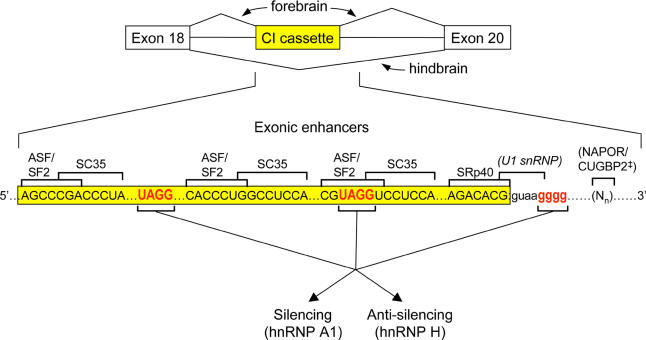
Model for Differential Regulation of the CI Cassette Exon by the Interplay of hnRNP A1 and H and a Ternary Motif PatternAt the top is a schematic of intron/exon structure and prominent splicing patterns observed in the forebrain (top) and hindbrain (bottom) of rat brain. Below is a summary of splicing regulatory motifs functionally defined in this study depicted on an expanded version of the GRIN1 CI cassette exon (yellow). ESEs are indicated above the exon. Nucleotides complementary to U1 small nuclear RNA and the interaction of the positive regulator NAPOR/CUGBP2 with the downstream intron are indicated (‡; as determined in [26]). UAGG and
GGGG splicing silencing motifs defined in this study are highlighted in red. The working model for splicing silencing, based on the results shown here, proposes that the CI cassette is a strong exon silenced by a combination of two exonic UAGG motifs and a 5′-splice-site-proximal
GGGG. HnRNP A1 mediates silencing and hnRNP H mediates anti-silencing via these RNA signals.